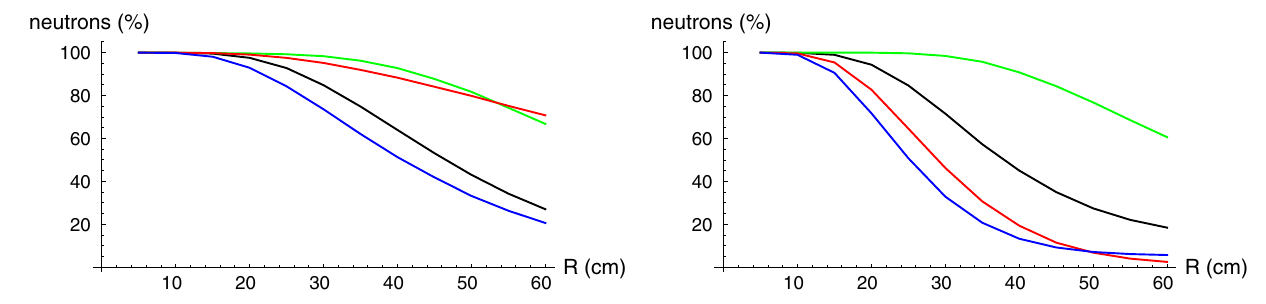
0.028 eV before escaping or being absorbed. The black, blue, red and green curves represent the LiOD, LiOD · D 2 O, solution and FLiBe con- verters respectively. The horizontal axis is the radius of the